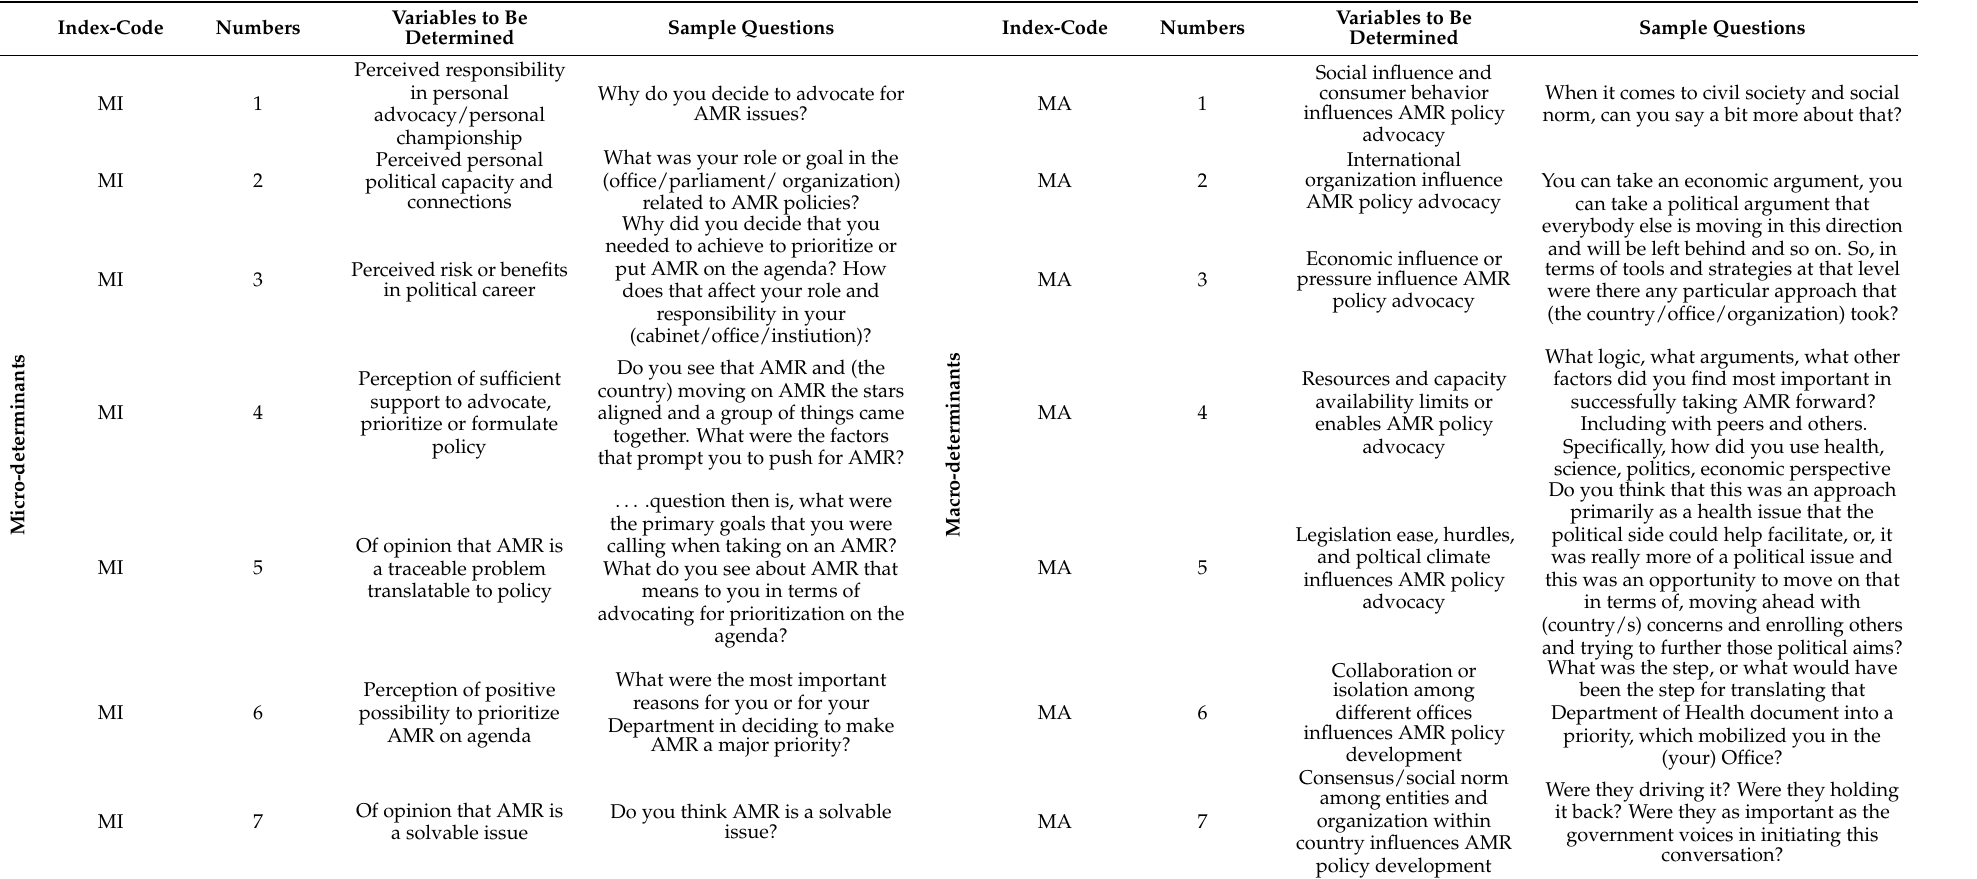
Table 1. Core interview variables and sample questions categorized as micro-, meso- and